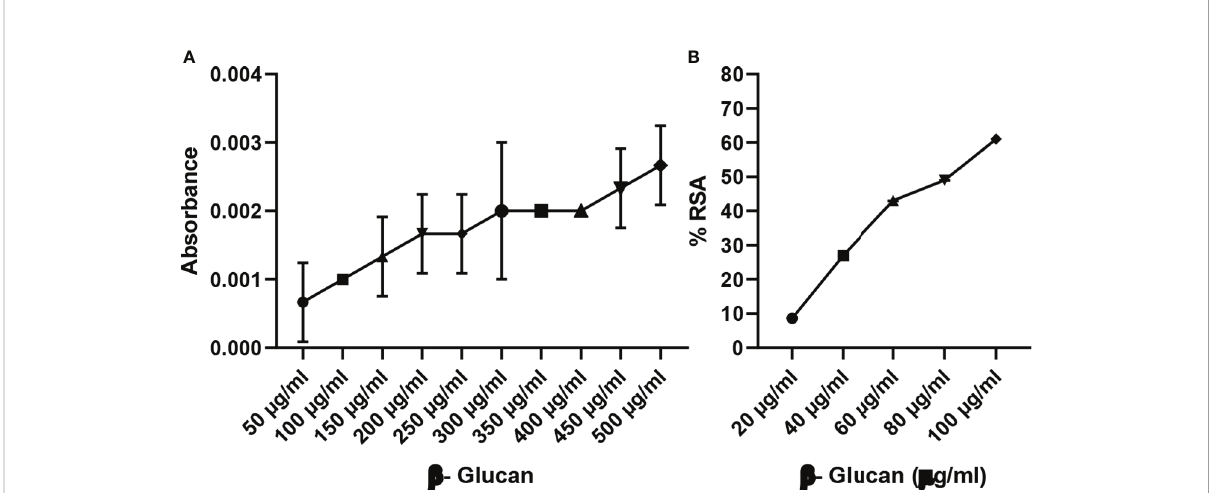
FIGURE 8 (A) Reducing power of yeast b -glucan. (B) DPPH assay. Free radical scavenging activity of yeast b -glucan was observed and was found to increase with increase in concentration. IC 50 was found at 82 m g/ml. All the data are expressed as the mean ± standard deviation of the mean (SD) from triplicate experiments.